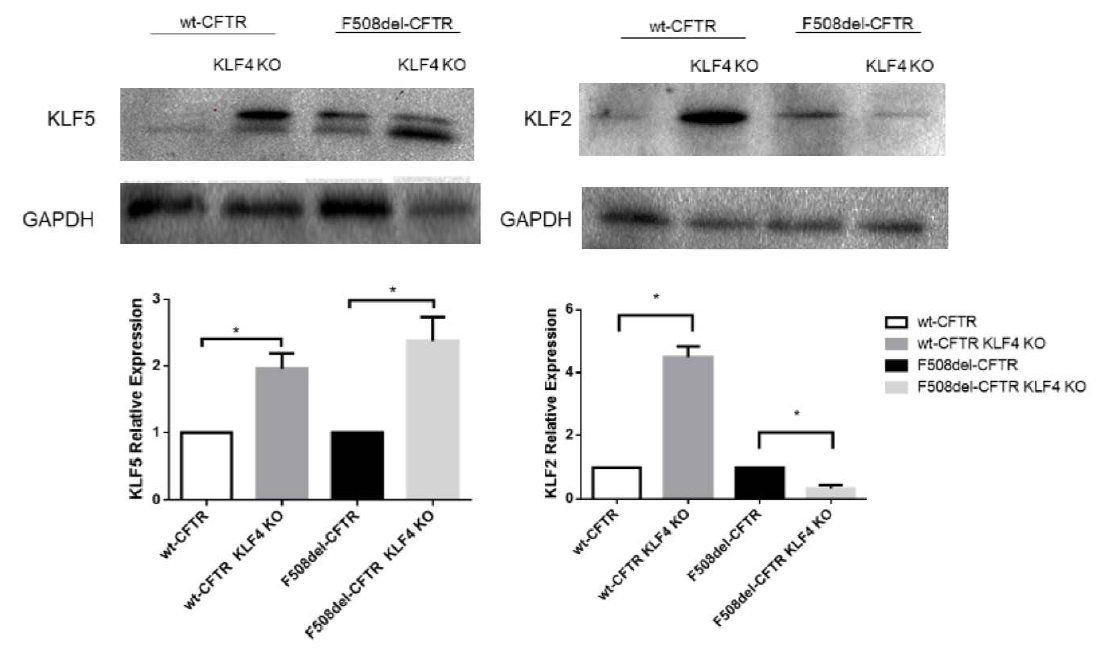
Figure 3. Impact of KLF4 KO on KLF2 and KLF5 levels. Protein levels in wt- and F508del-CFTR CFBE and their respective KLF4 KO counterparts. Representative WB of KLF2 and KLF5. GAPDH was used as loading control. Data are normalized to loading control and showed as relative expression (KO vs. non-KO; n = 3, unpaired t -test, * is p <